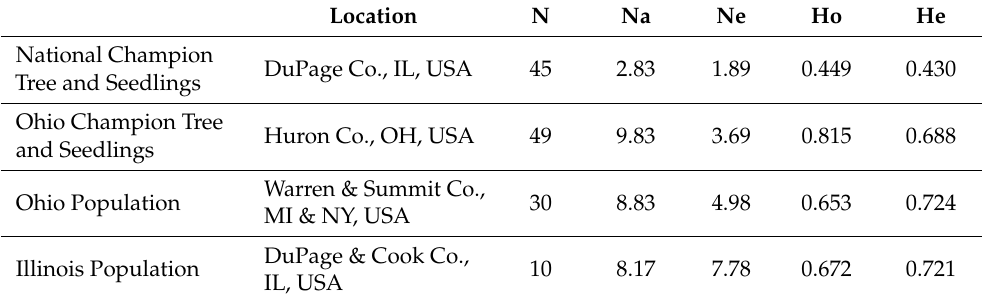
Table 1. List of samples genotyped for this study and descriptive